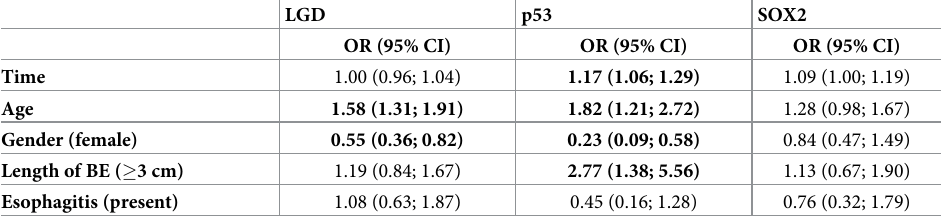
Table 2. Risk of aberrant expression of biomarker. Longitudinal models: ORs and 95% CI of the risk of having LGD, aberrant expression of p53, or SOX2 in time, adjusted for age, gender (at baseline), length of BE, and esophagitis (time-varying covariates). OR > 1 indicate an increased probability of LGD or aberrant expression of p53 or SOX2 if the mentioned characteristic is